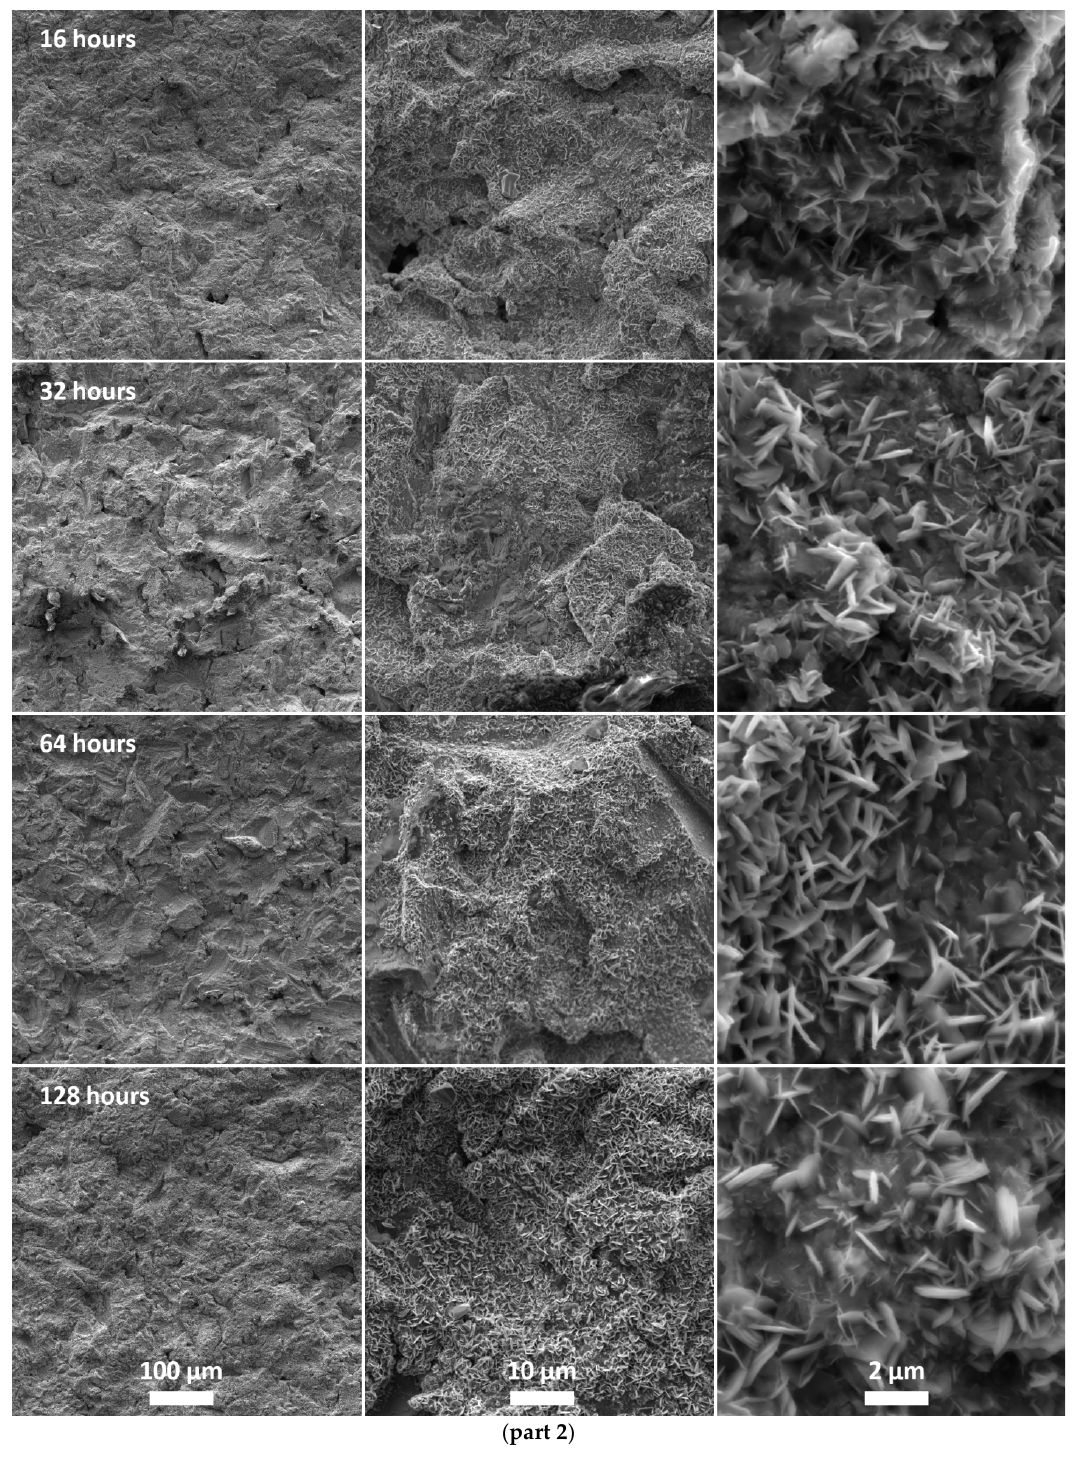
Figure 1. Scanning electron microscopy images at 1000 × (left), 10,000 × (middle) and 50,000 × (right) magnification: part 1 —unannealed sample and samples annealed for 2, 4 and 8 h; part 2 —samples annealed for 16, 32, 64 and 128 h.